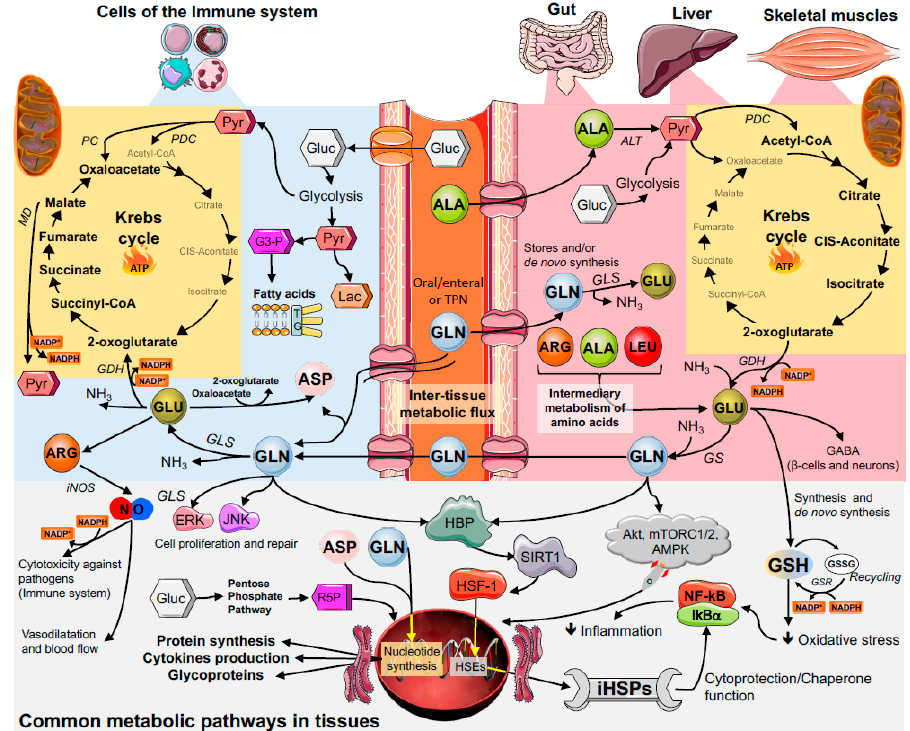
Figure 3. Glutamine inter-tissue metabolic flux starting in skeletal muscle, liver, and gut continues in